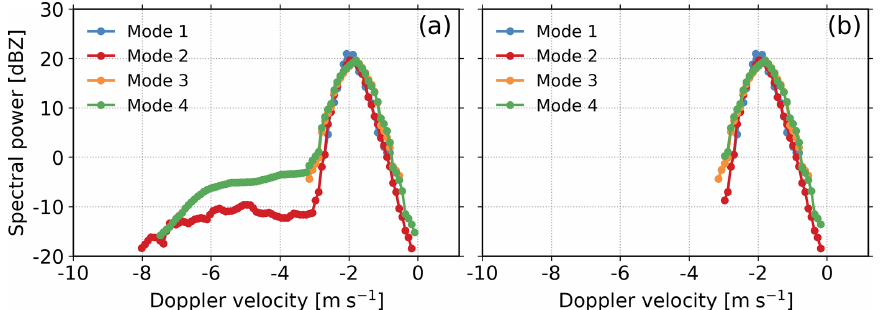
Figure 6. Ku-band Doppler power spectra recorded at different modes at 5.01km on 6 June 2020 at 22:52:08LST. (a) Noise-removed Doppler spectrum; (b) the same as (a) but after the removal of range